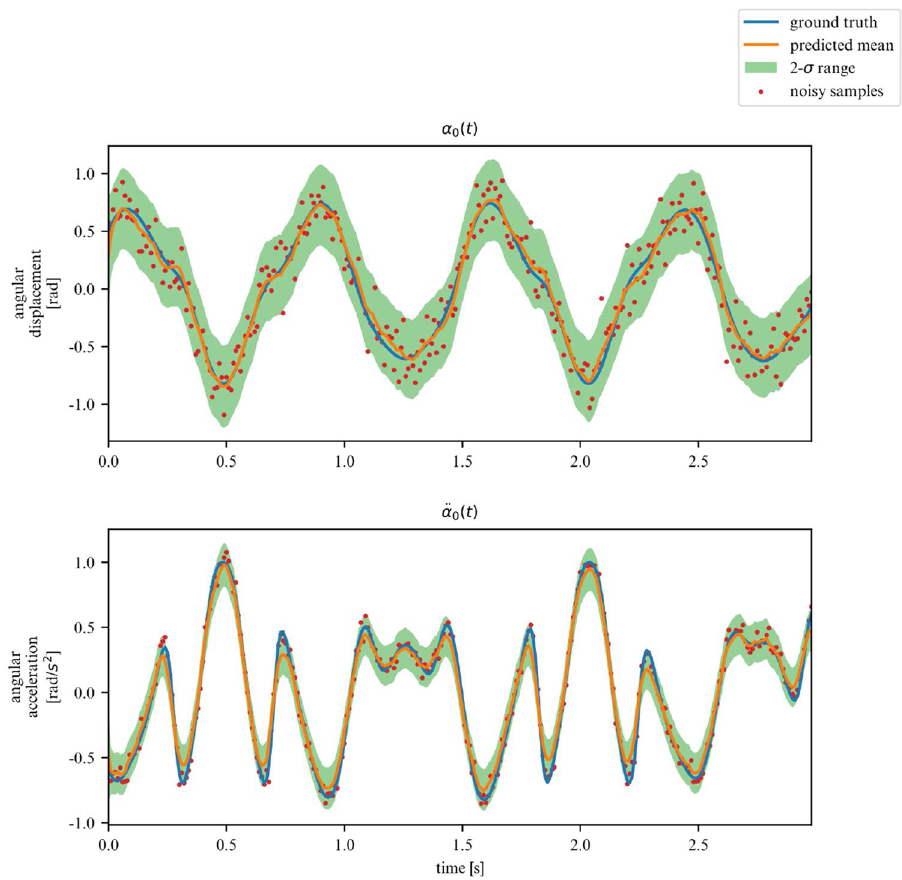
Figure 22. Partially observed double pendulum